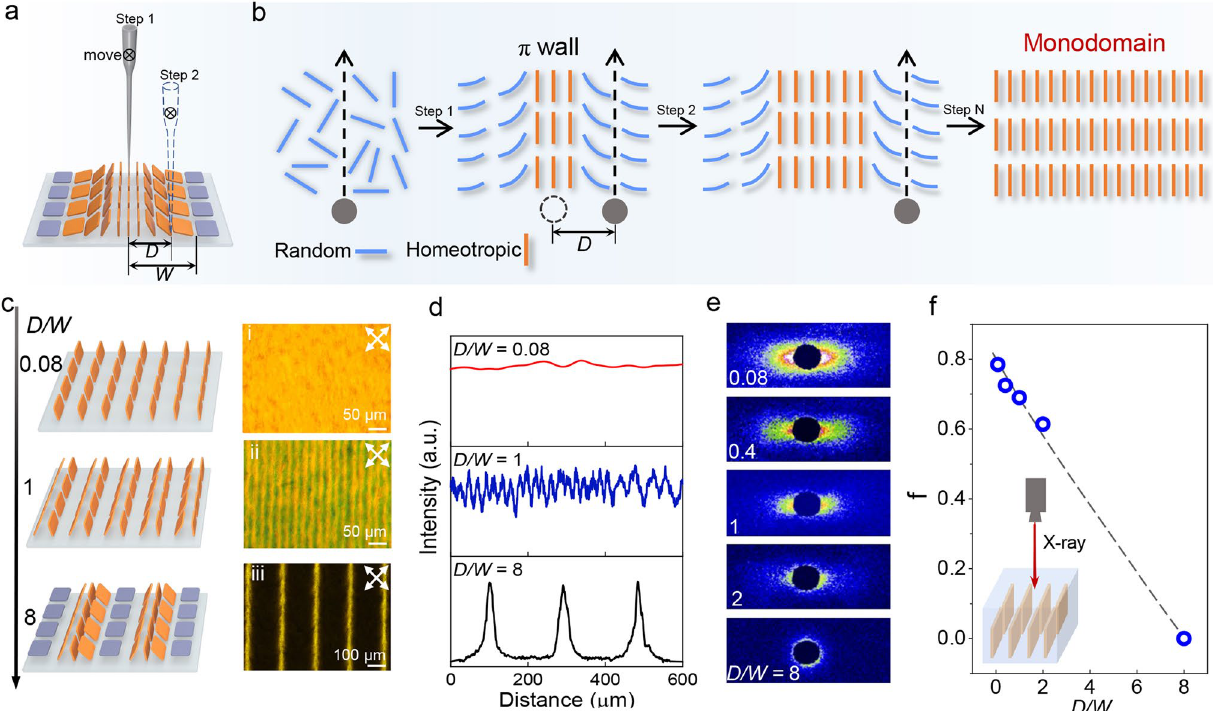
Fig. 1 a Schematic of boundary-free sheargraphy method. W is the half width of a π wall and D is the distance between two adjacent localized shearing fields. b The fabrication of GO MDLCs by controlling cumulative micron-scale shearing field. Step N is the number of cumulative shearing. c Three topological architectures of GO LCs as a function of D/W , (i) D/W = 0.08, (ii) D/W = 1, (iii) D/W = 8. All POM images were viewed with boundary lines at 45° to the polarizers. d Transmission intensity of POM images. e SAXS patterns. f The orientation order param- eter ( f ) as a function of